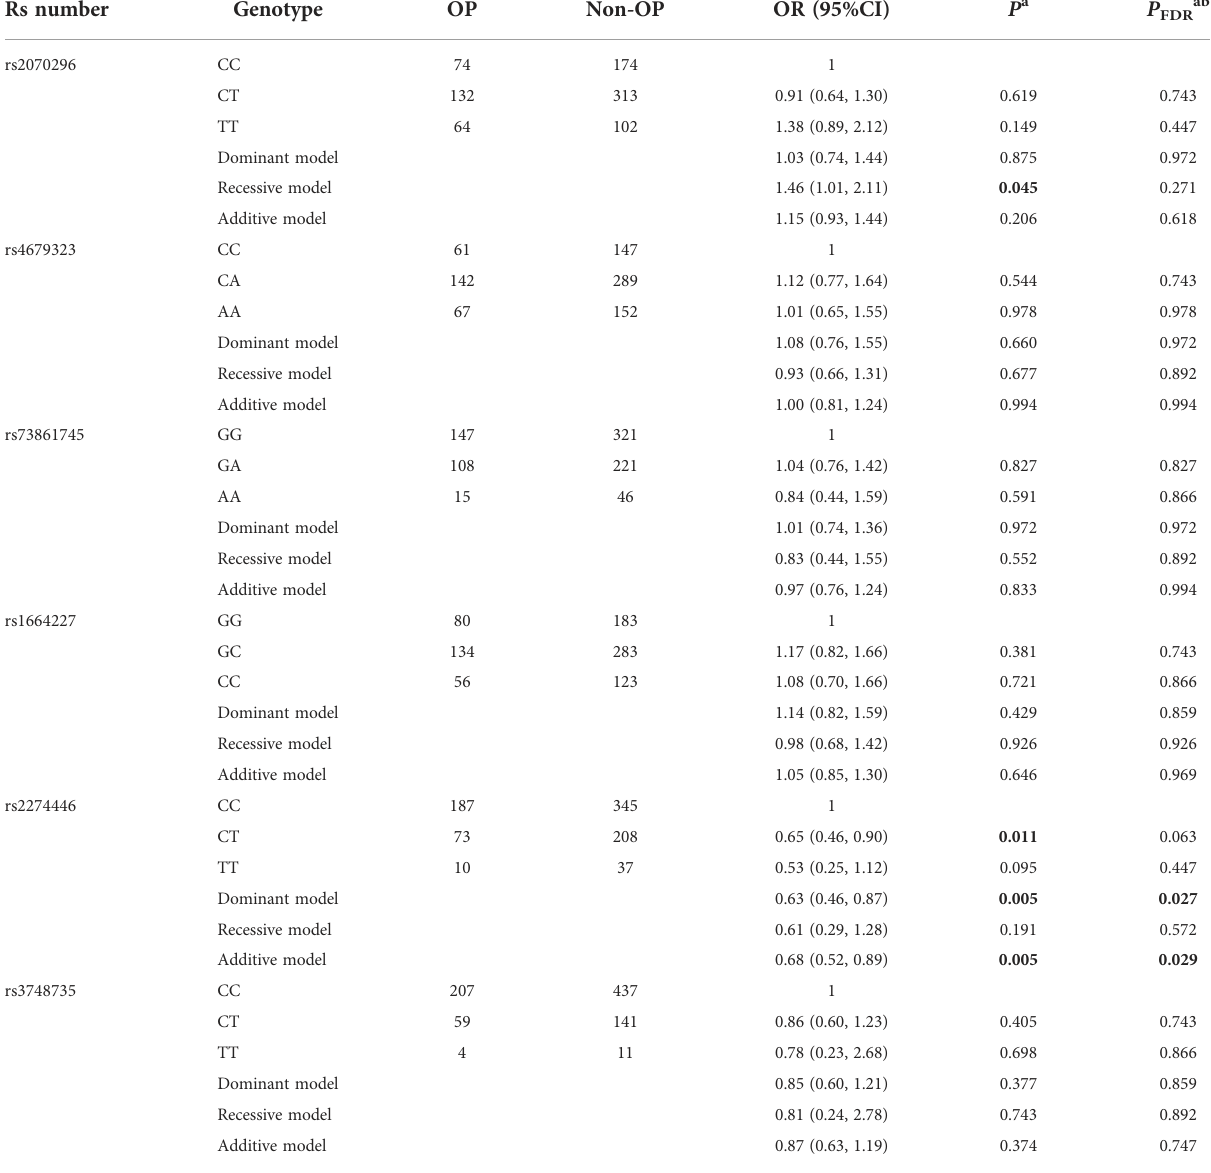
TABLE 2 Multivariate logistic regression results of associations between common genetic variants and OP risk in the validation stage. Rs